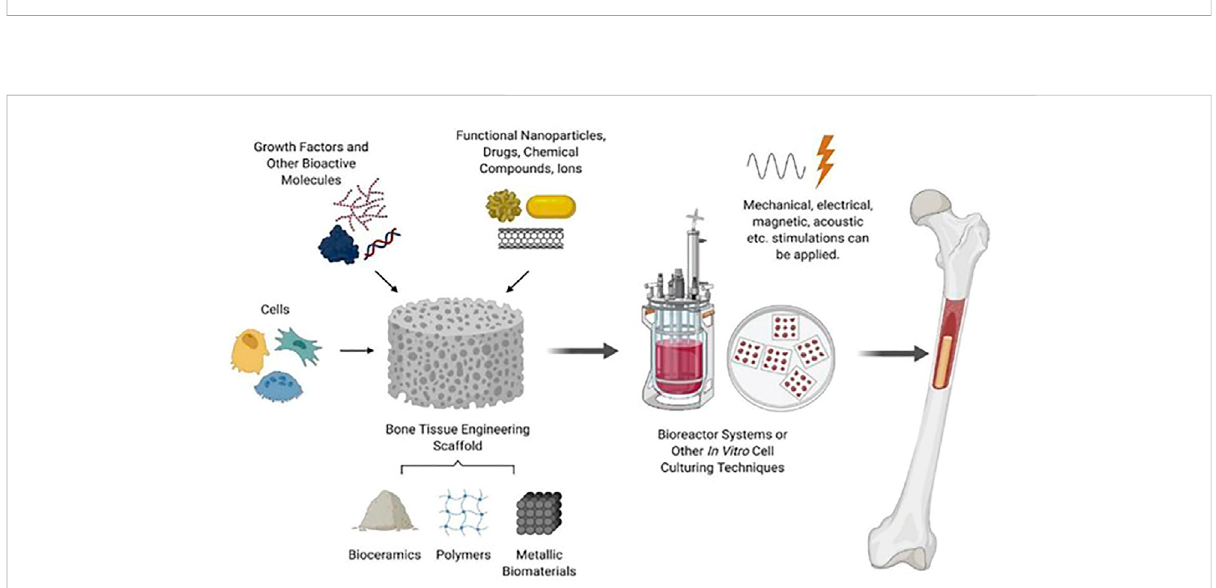
FIGURE 2 A summary of zeolites used in biomedical fi